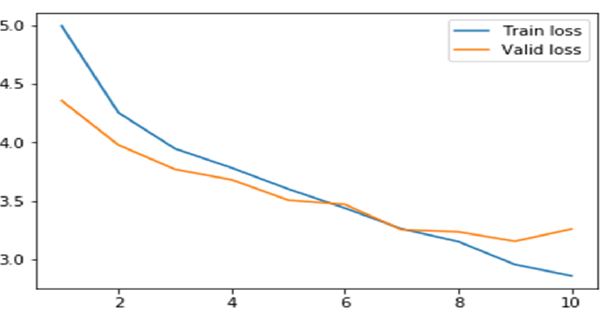
Figure 19. Total loss for the proposed model with an LR 0.0006 and 10 epochs.